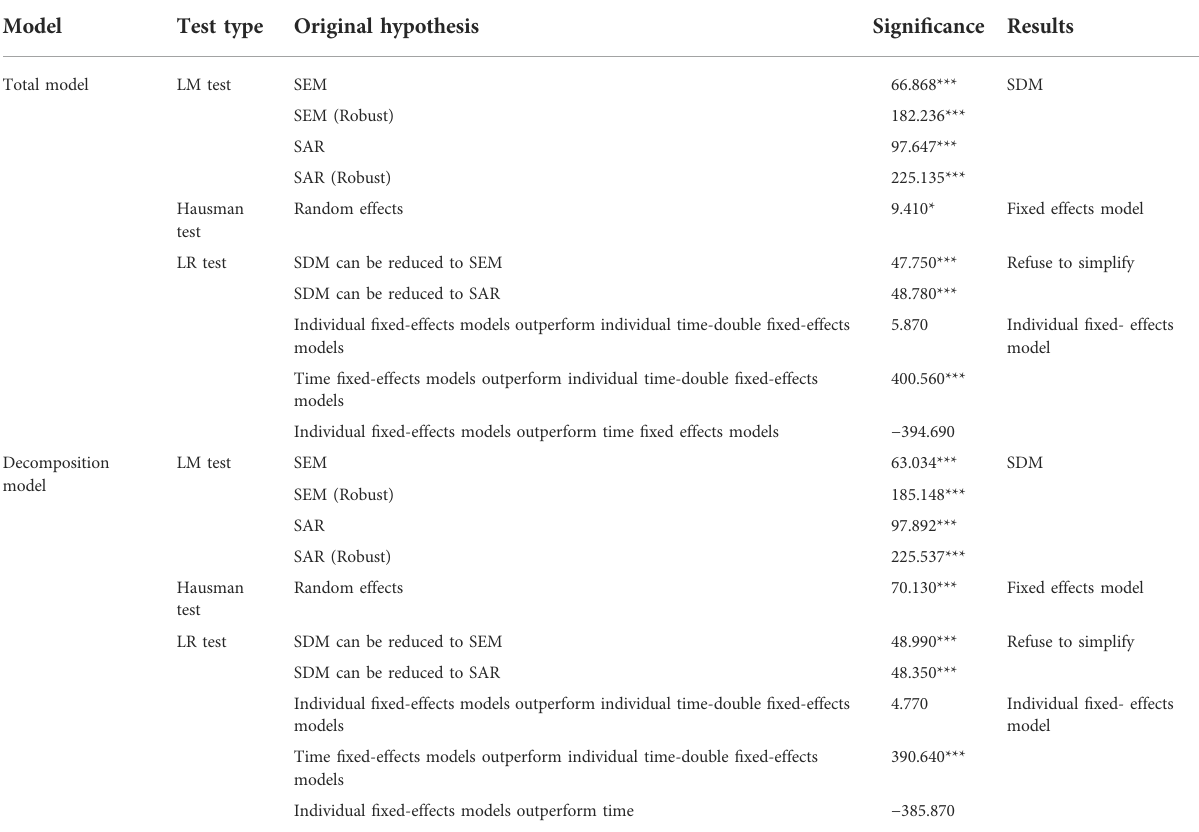
TABLE 8 Related test